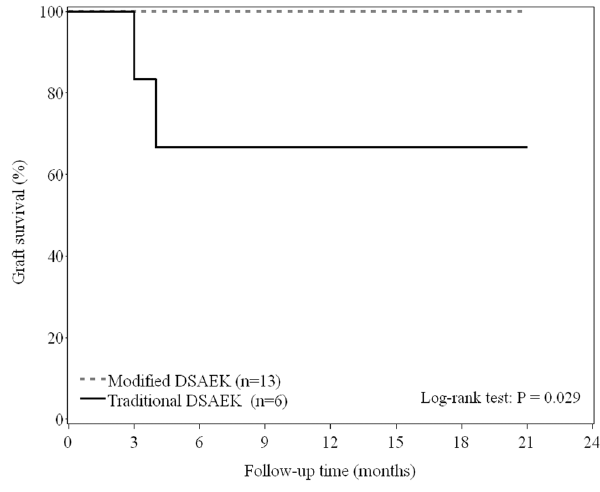
Figure 3. Estimated graft survival determined by Kaplan-Meier